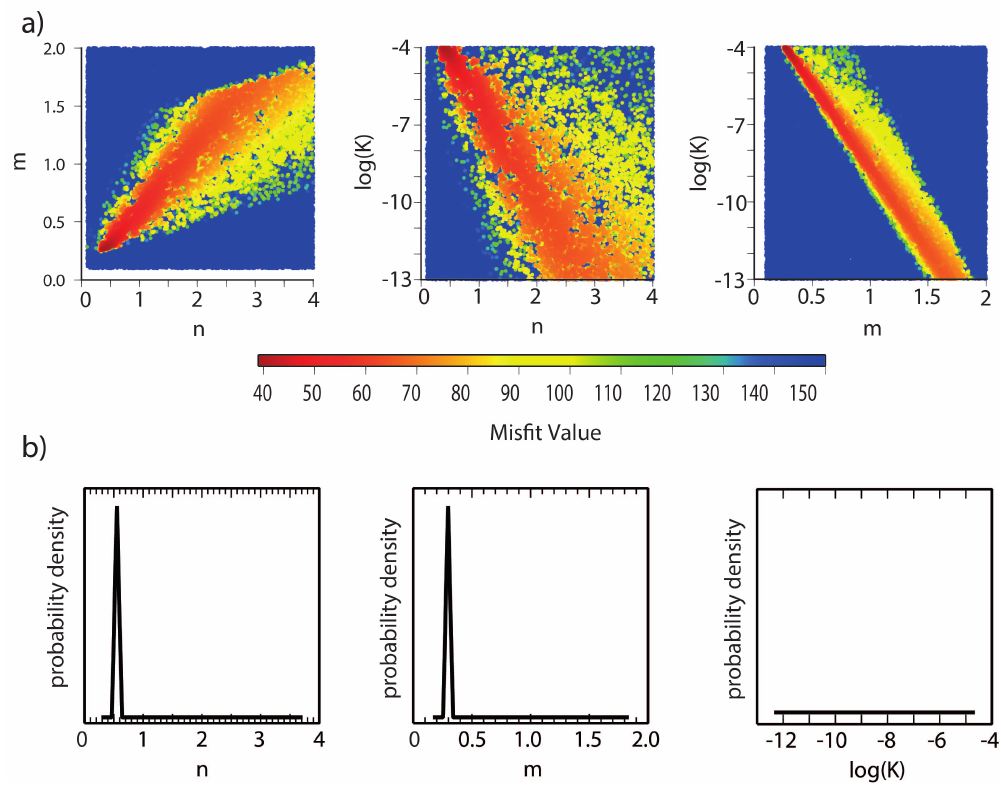
Figure 6. Results from inversion for the free parameters K , m and n . (a) Scatter plots showing the results from NA sampling stage. (b) PDFs of the three parameters resulting form the appraisal stage of